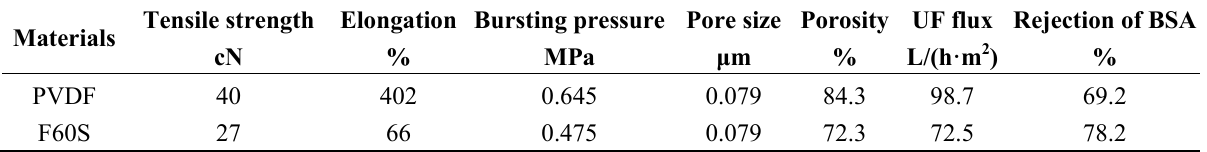
Table 2. The mechanical and permeation performance of the PVDF and F60S membranes. Materials